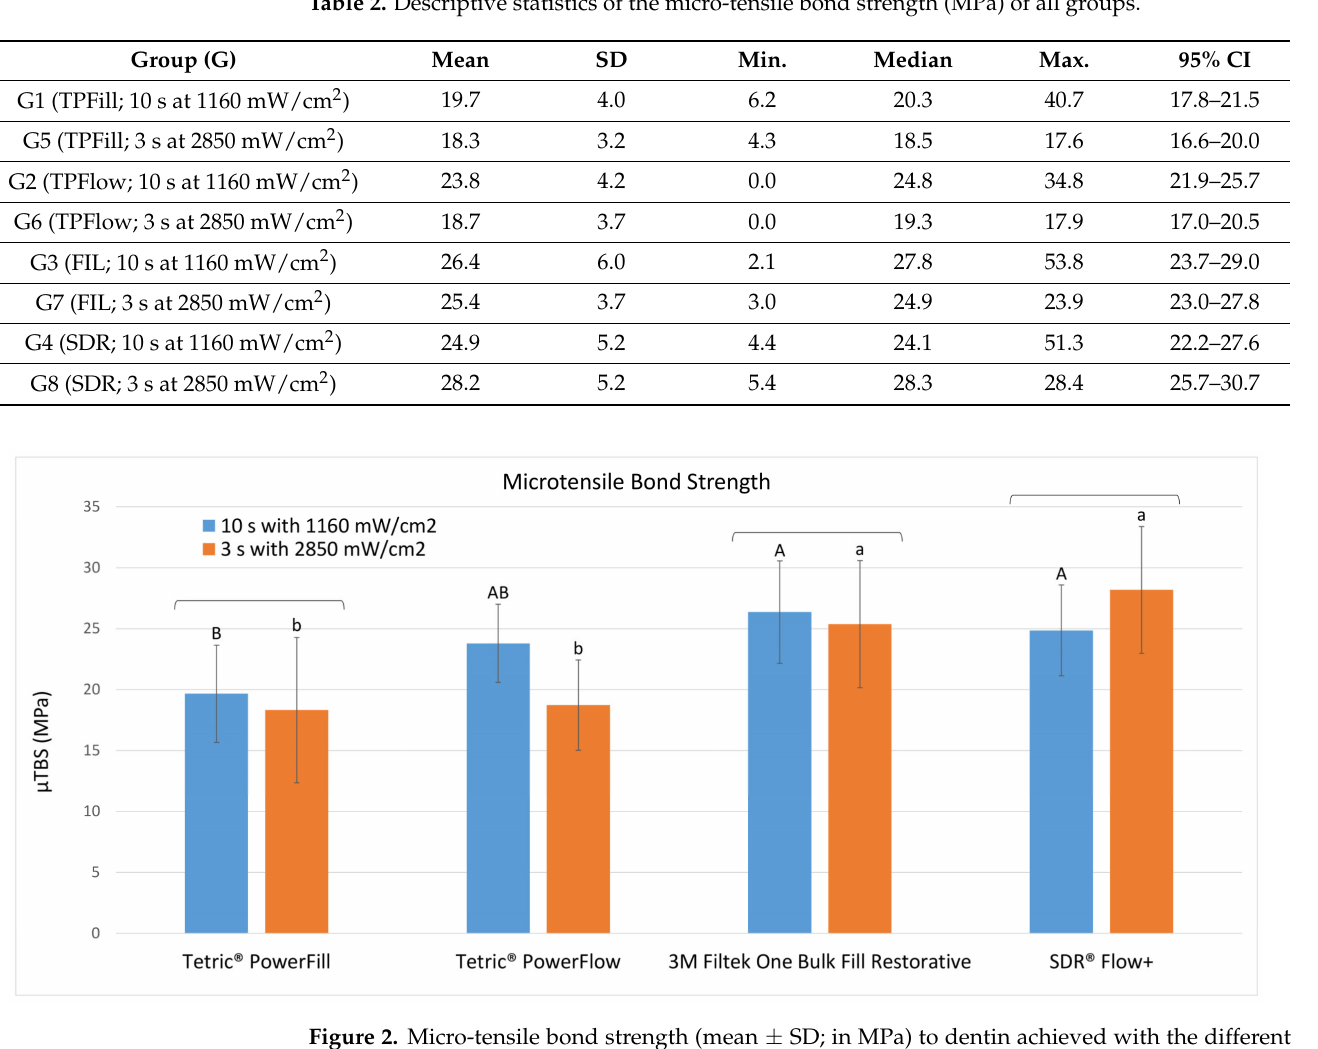
Figure 2. Micro-tensile bond strength (mean ± SD; in MPa) to dentin achieved with the different light-curing protocols. Square brackets above the bars show statistically similar results between the curing protocols (“10 s” vs. “3 s”) within each material. Same uppercase letters indicate statistically similar results among materials for the “10 s” curing protocol. Same lowercase letters indicate statistically similar results among materials for the “3 s” curing